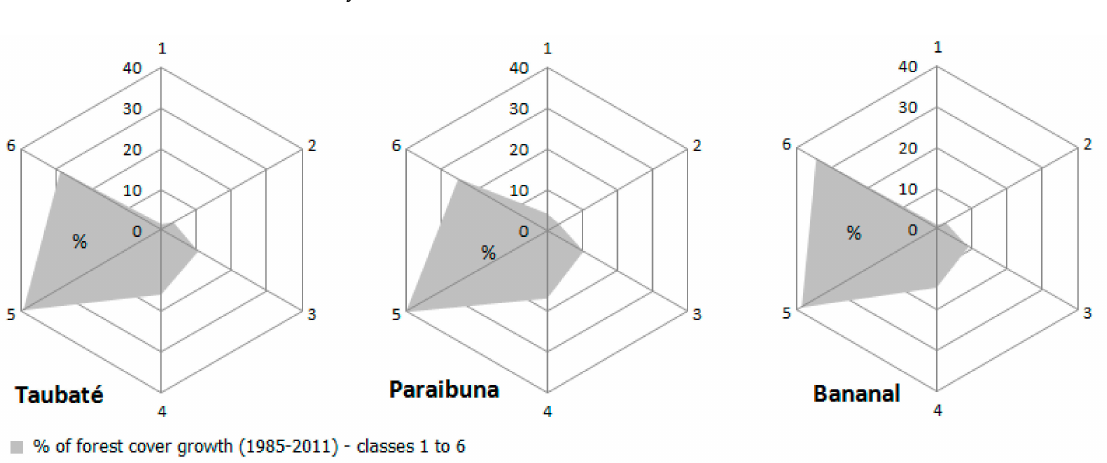
Figure 5. Percentage of forest cover growth in the studied municipalities of the Para í ba Valley,